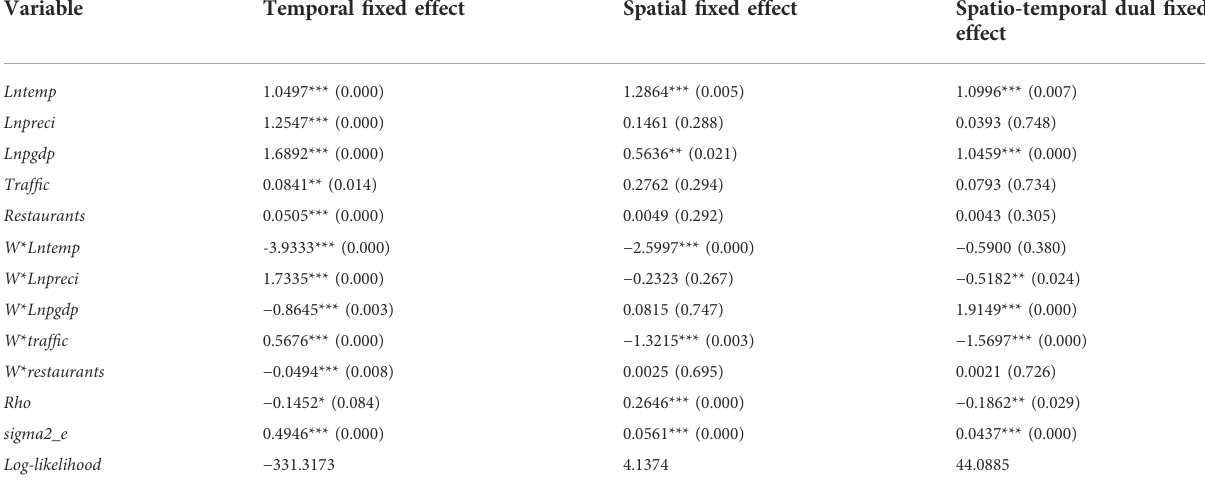
TABLE 4 Regression results of the SDM with different